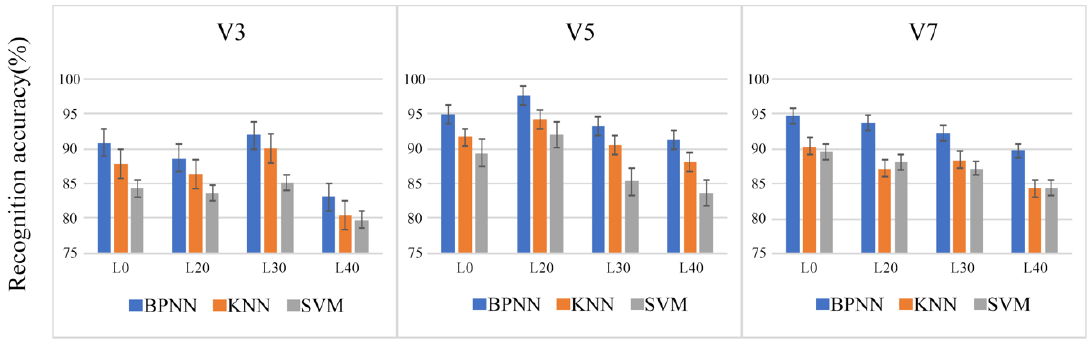
Figure 4. Comparison of three classification algorithms at four different loads under three different speeds.